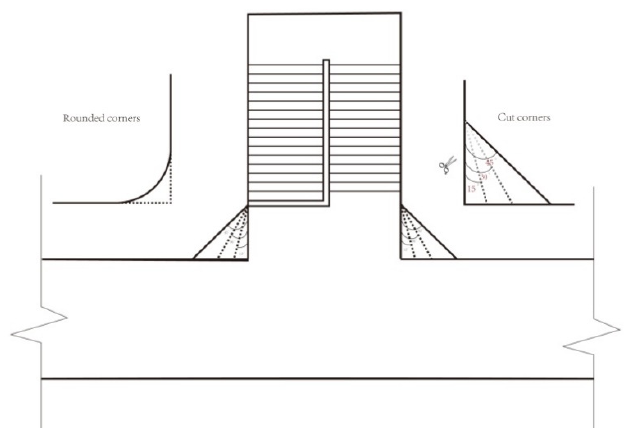
Figure 12. Right angle, cut (angle α : 15°, 30°, 45°), and rounded corner designs in the antechamber of the staircase.